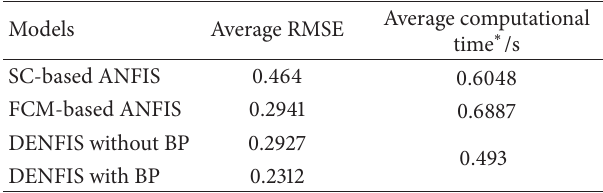
Table 4: Test performance of the NF models (high tech).